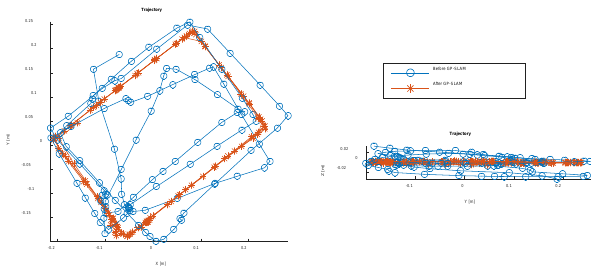
Figure 6: Estimated trajectory from repeating a rectangular path four times in a heterogeneous magnetic